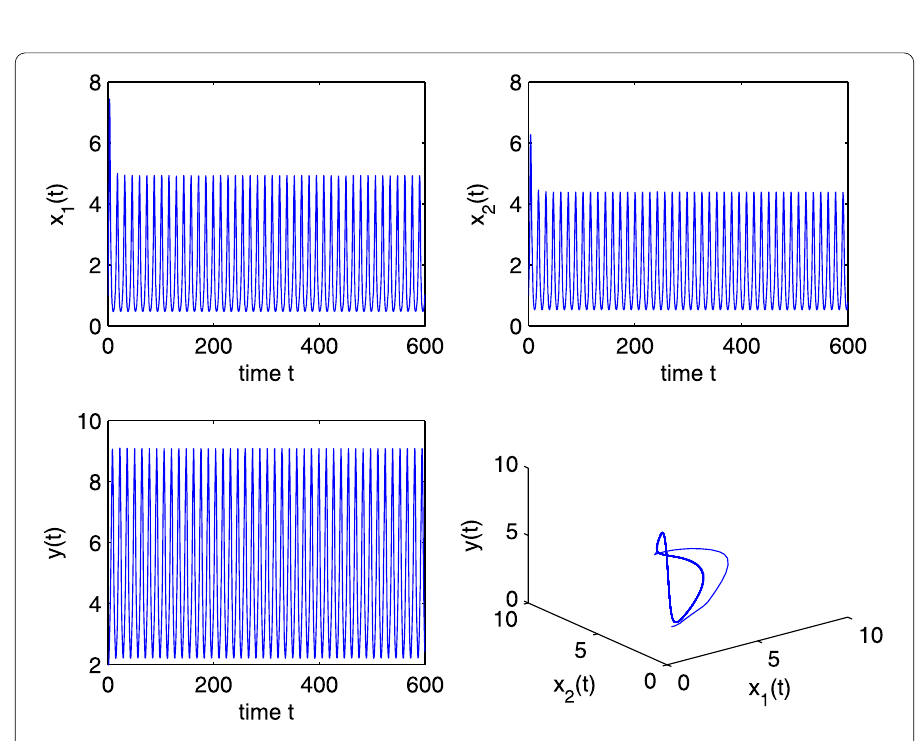
Figure 4 When τ 1 = τ 2 = τ , E ∗ undergoes a Hopf bifurcation for τ = 1.8 > τ 0 =